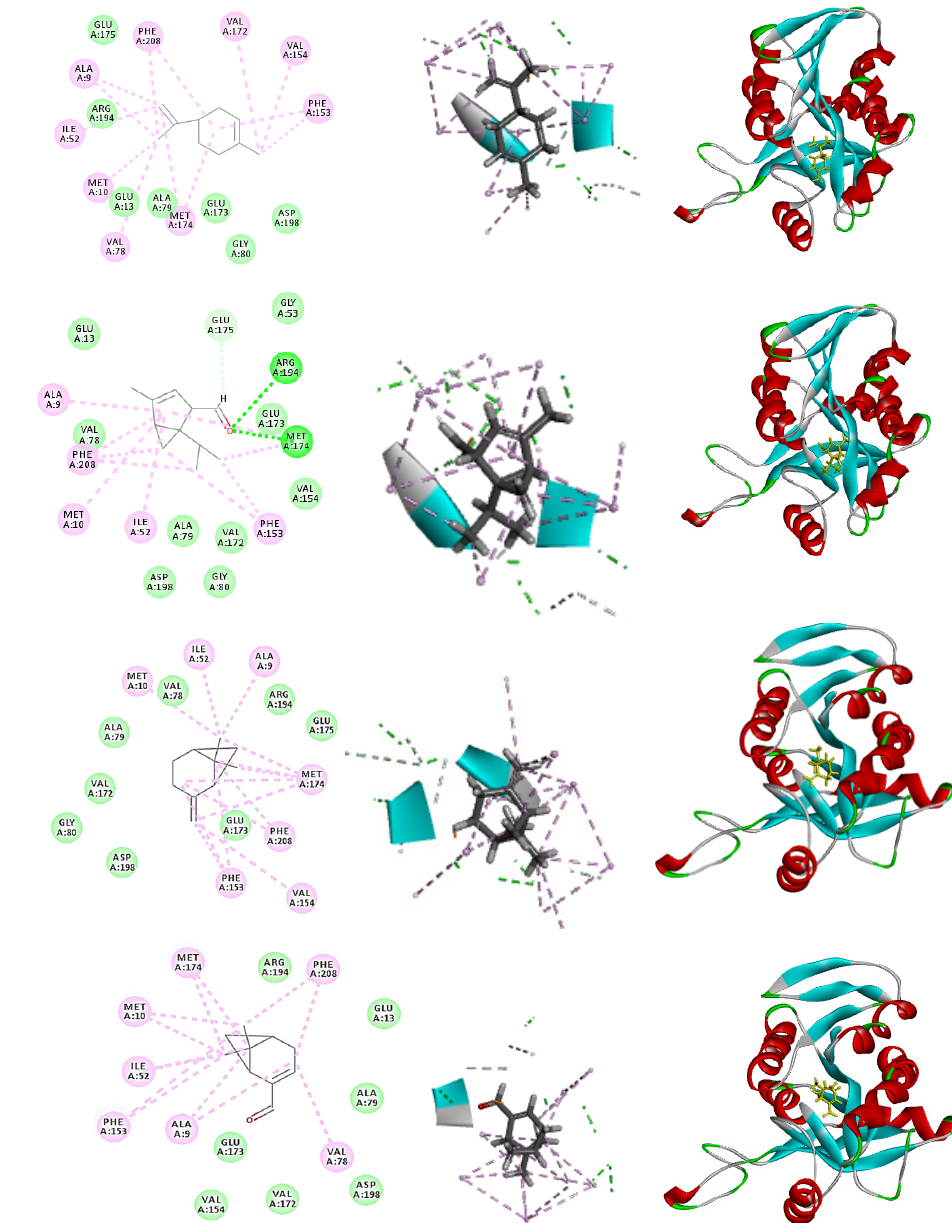
Figure 4. 2D and 3D interaction diagram of the co ‐ crystallized ligand and identified compounds docking pose interactions with the key amino acids in the 3NM4 binding site. The three-letter amino acid codes and positions of each residue are indicated. Between the receptor and the ligand, hydrogen ‐ bonding interactions are illustrated by a green dashed line, whereas ‐ alkyl interactions are represented by a purple dashed line.